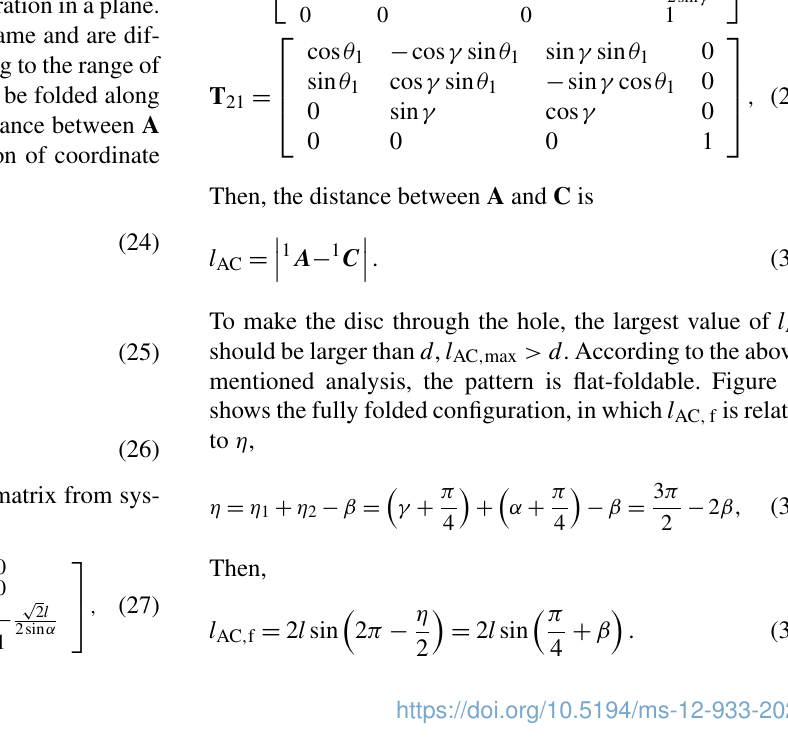
All curves pass through the point ( π , π ), which represents the deployed configuration in a plane, and pass the point (0, 0), which represents the fully folded configuration in a